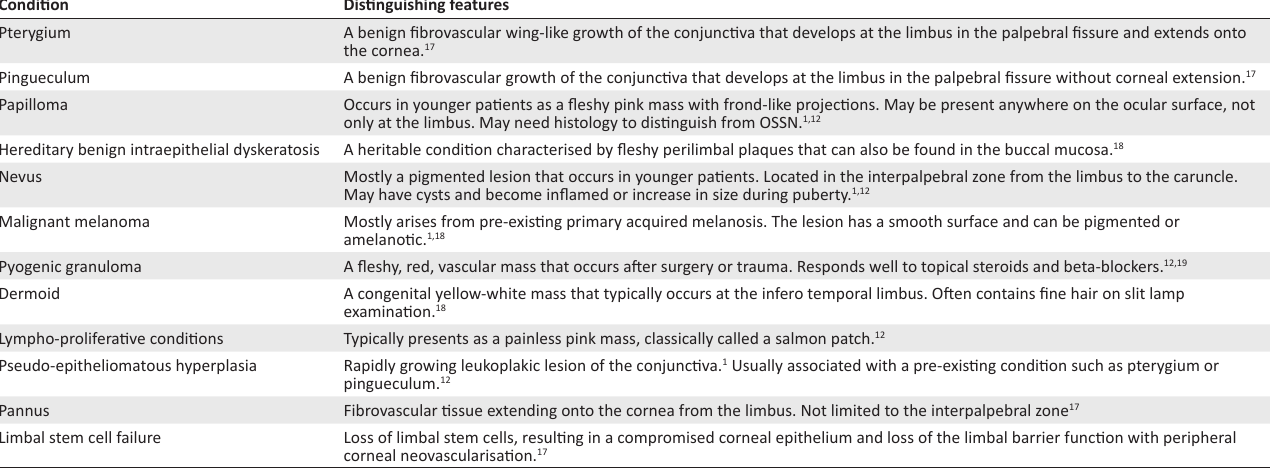
TABLE 2: Differential diagnosis of ocular surface squamous neoplasia and its distinguishing features.